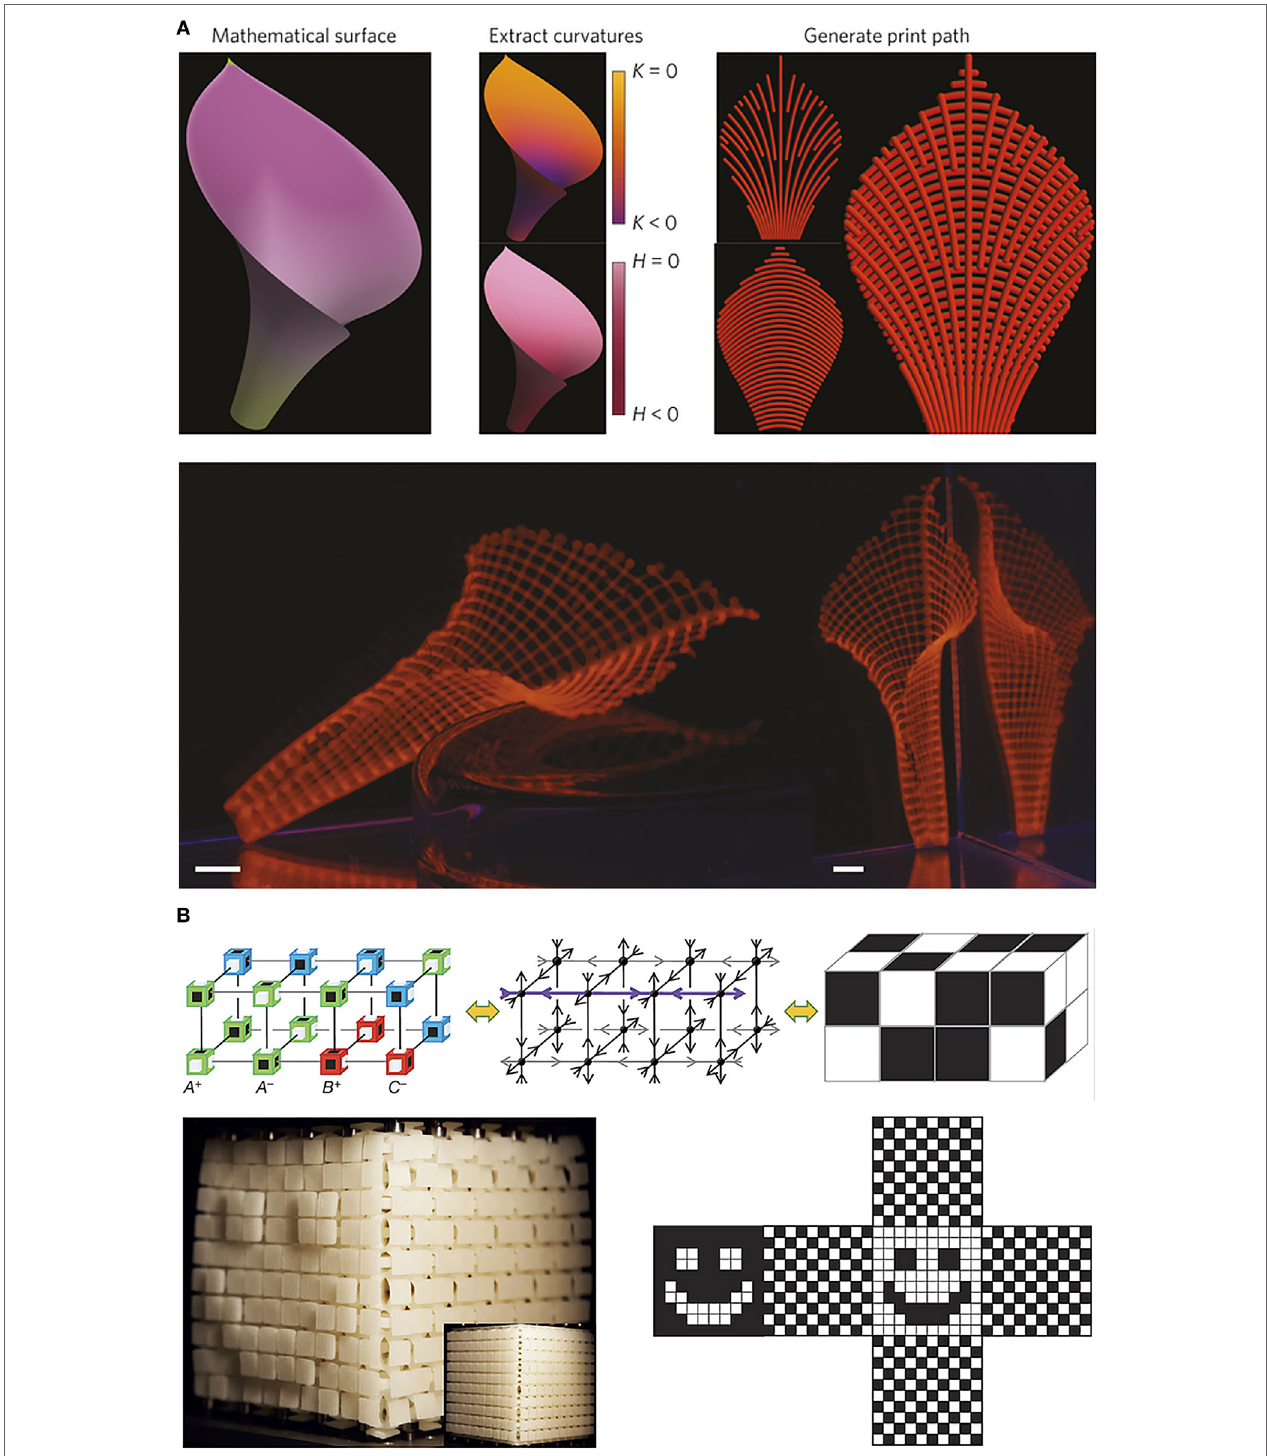
FigURe 3 | examples of current developments where computational modeling is combined with additive manufacturing to acquire advanced functionalities . Panel (A) shows an example of biomimetic 4D printing, where composite hydrogel architectures that are encoded with localized, anisotropic swelling behavior, are printed in designs that result in a predictable and controllable shape change when the objects are hydrated. Panel (B) shows an example where anisotropically deforming cubic building blocks are combined using three-dimensional printing. By computationally designing the relative placement of multiple building blocks, predictable surface textures can be created when exposed to uniaxial compression or extension. Adapted with permission from Gladman et al. (2016) and Coulais et al. (2016),